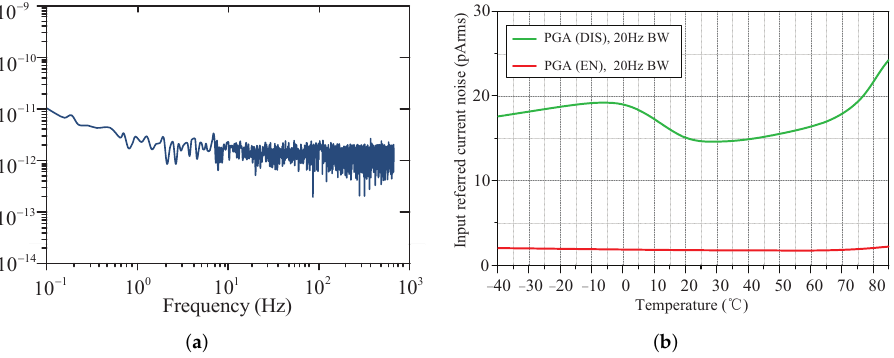
Figure 12. ( a ) The input current noise spectrum of RX. ( b ) The input referred current noise of RX in the varying temperature from –40 ◦ C to 85 ◦